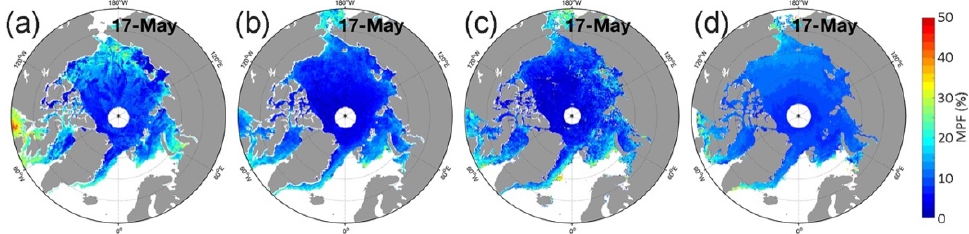
Figure 18. Spatial averaged MPFs on May 17 during 2003–2011. ( a ) Regressed MPF (regressed by surface reflectance), ( b ) DNN_MPF, ( c ) UH_MPFv2, ( d ) UB_MPF.